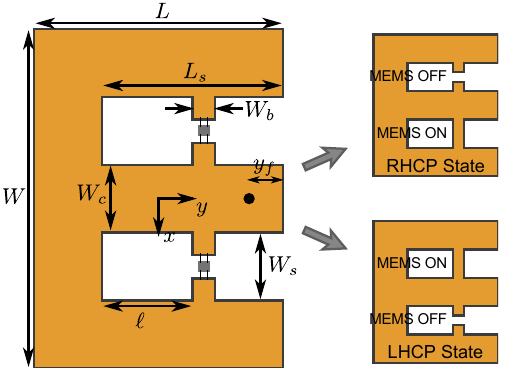
FIGURE 22. Configuration of the MEMS RHCP/LHCP reconfigurable E-shaped patch antenna element to produce either RHCP or LHCP modes. Adapted from [17].